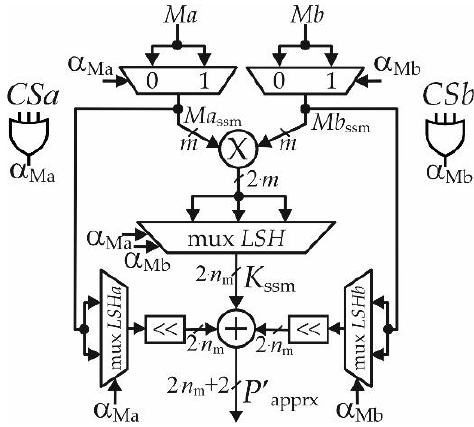
Figure 5. Segmented MAA that implements Equation (11).